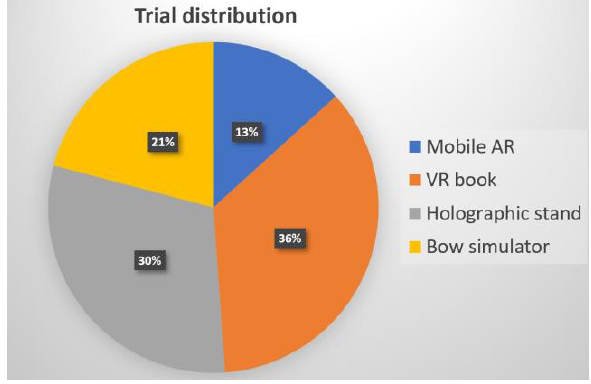
Figure 6. Equipment